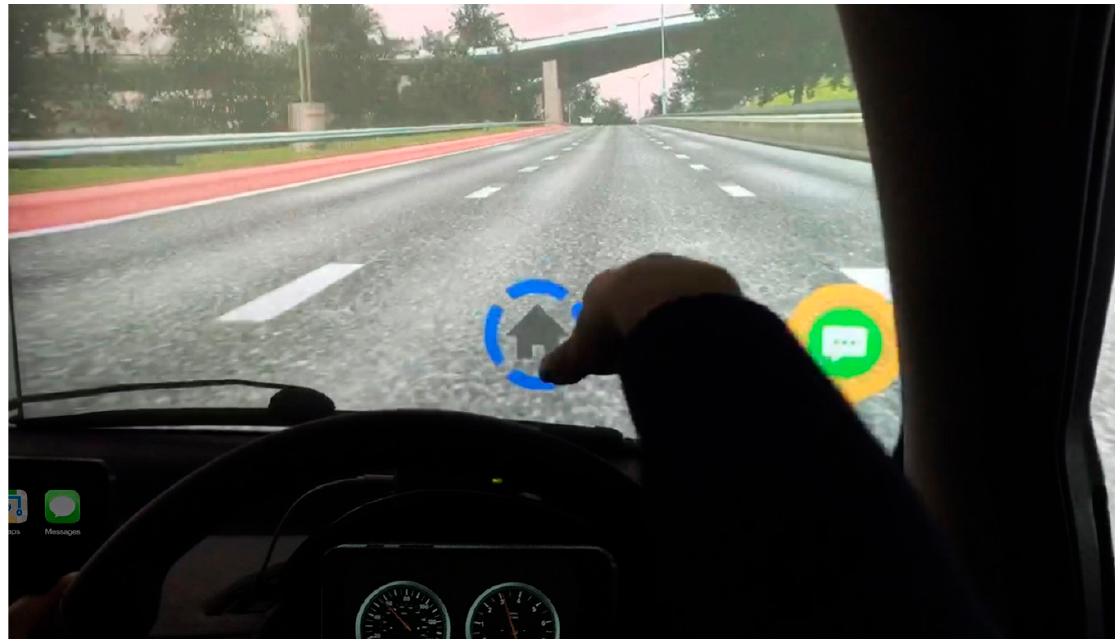
Figure 2. Screenshot of the fully functional AR HUD and conventional HDD interfaces in the VR driving simulator.